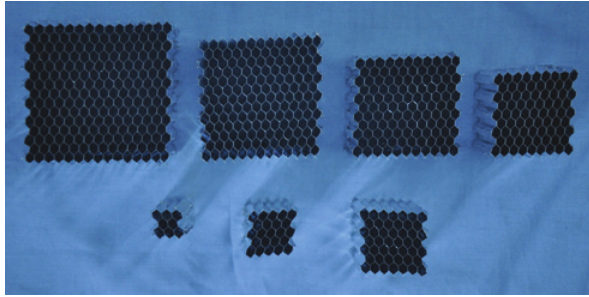
Figure 2 Seven honeycomb specimens with different cell numbers.